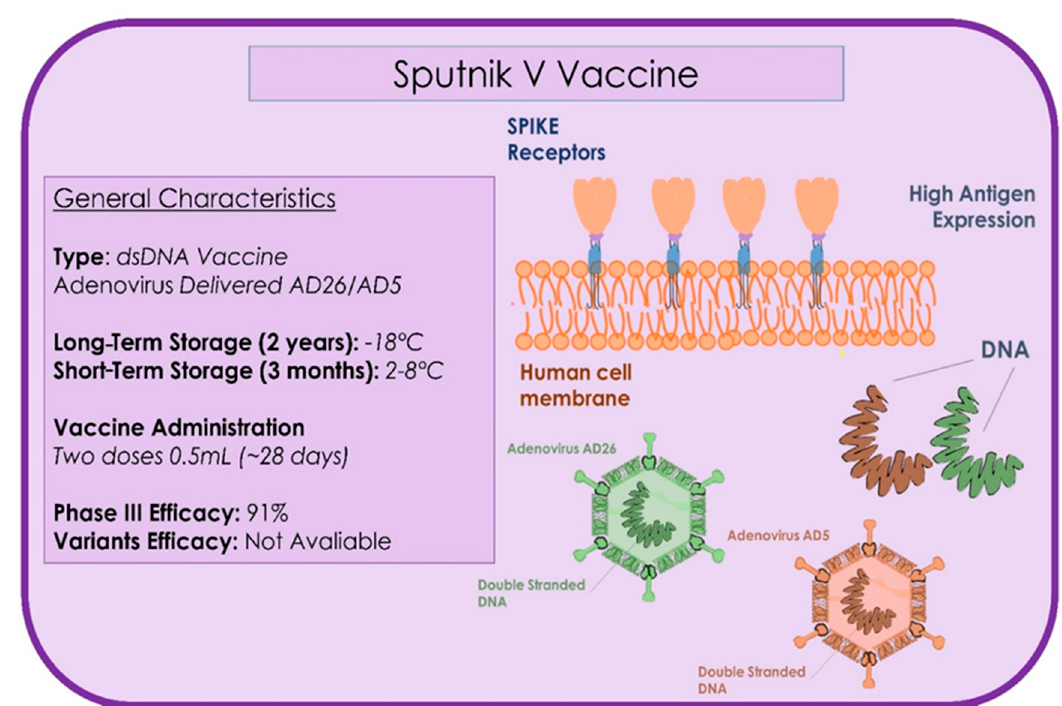
Figure 9. Summary of the type, storage administration, and efficacy characteristics of the Sputnik vaccine.